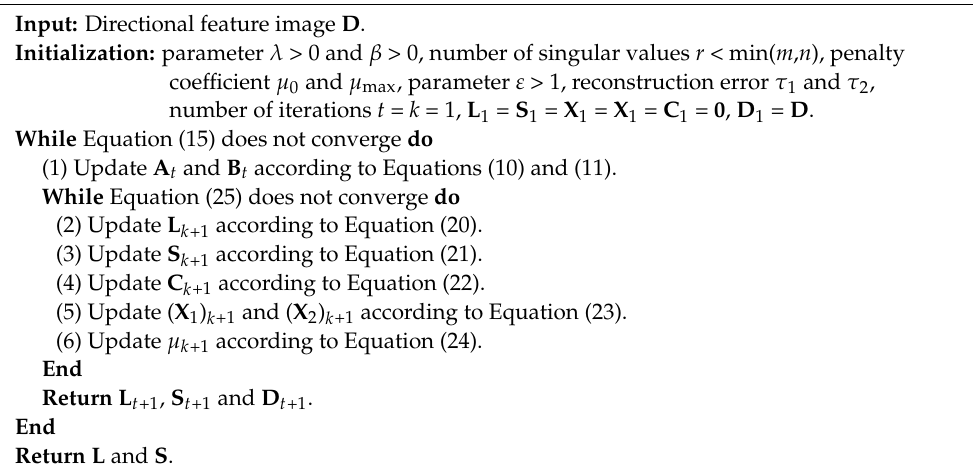
Algorithm 1 Low–rank and sparse matrix decomposition with truncated nuclear